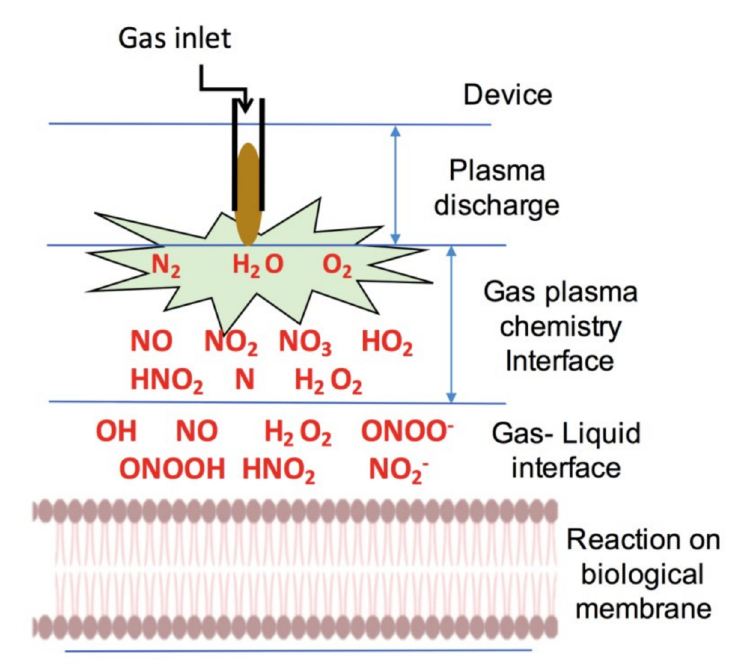
Figure 3. Di ff erent reactive species generated by gas plasma in air and in gas–liquid interfaces.